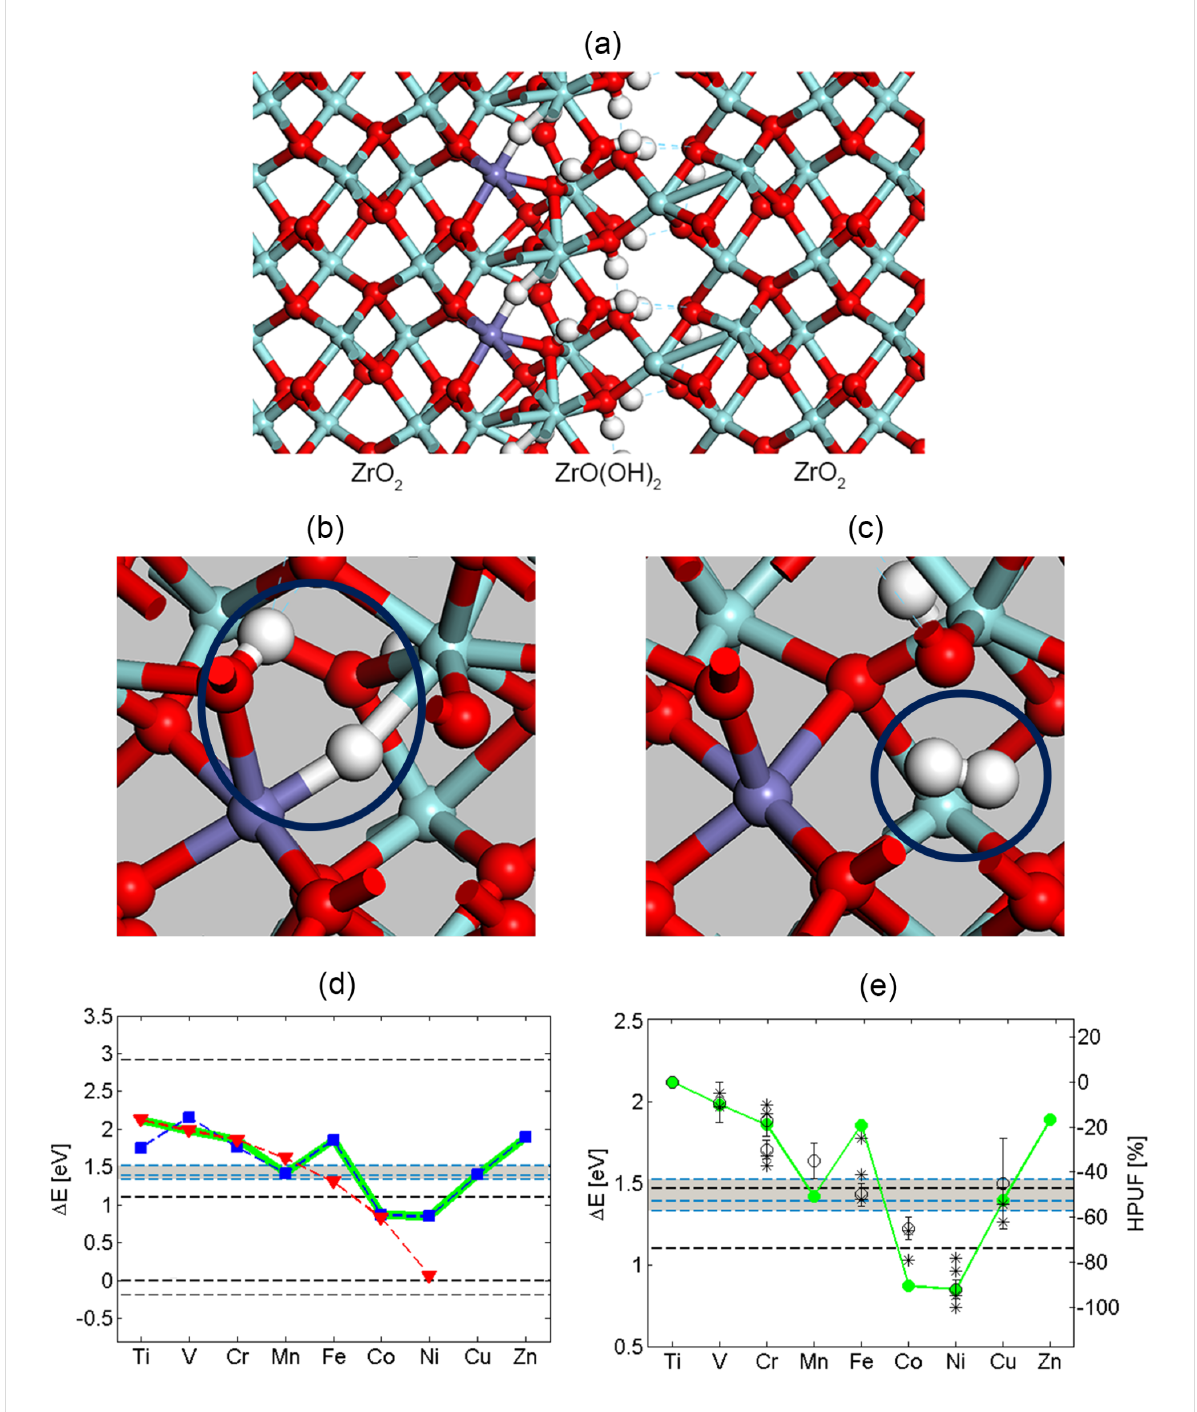
Figure 1: (a) Representative structure for a model of a hydroxylated inter-grain interface comprising ZrO(OH) 2 on ZrO 2 . Here, this interface is deco- rated with Fe ions with the oxidation state +2. Oxygen is represented as red, zirconium as light blue, iron as purple, and hydrogen as white. (b) One hydride ion and one hydroxide moiety prior to the hydride-proton recombination to form H 2 is displayed, reactant in Equation 6. (c) The product in Equation 6 is displayed, including M X coordination to the additional oxygen ion replacing the hydride ion and the released grain boundary H 2 . (d) Hydride-proton recombination energies for H 2 release into said interface (dashed black line at 1.1 eV), enthalpy change for H 2 release at ambient pressure (dashed black line at 0 eV), and corresponding Gibbs energy change (dashed black line at − 0.2 eV). TM 2+ blue, TM 3+ red, weighted average green. (e) Comparison of theoretical data (green) and experimental HPUF data (black); * from [7] and o from [8]. The theoretical data is a weighted average between TM 2+ and TM 3+ . The black dashed line is HPUF in pure ZrO 2 from [7]. The blue dashed line corresponds to HE from Zr 4+ hydride at GB with Na + , Ca 2+ and Sc 3+ spectator. Sc 3+ corresponds to the top line, Na + to the middle line and Ca 2+ to the bottom